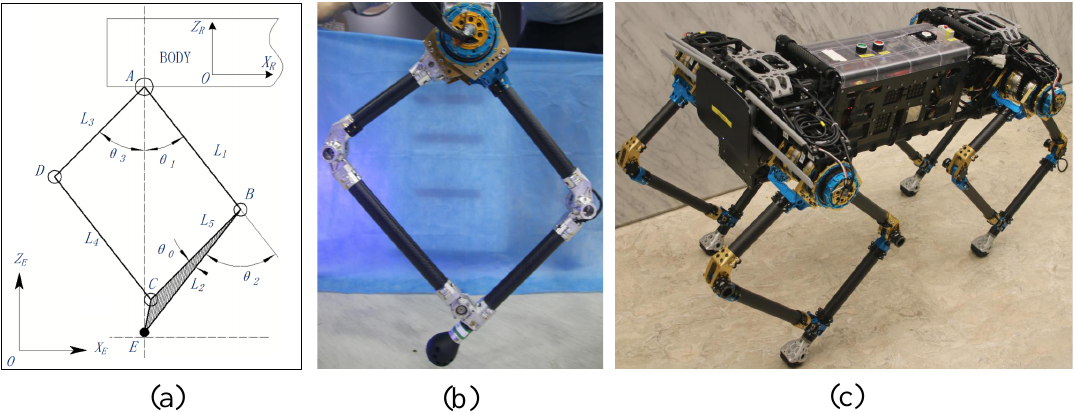
Figure 5. Single leg structure and overview of quadruped robot. ( a ) Accurate modeling of TP single leg, ( b ) TP single leg, ( c ) planar quadruped